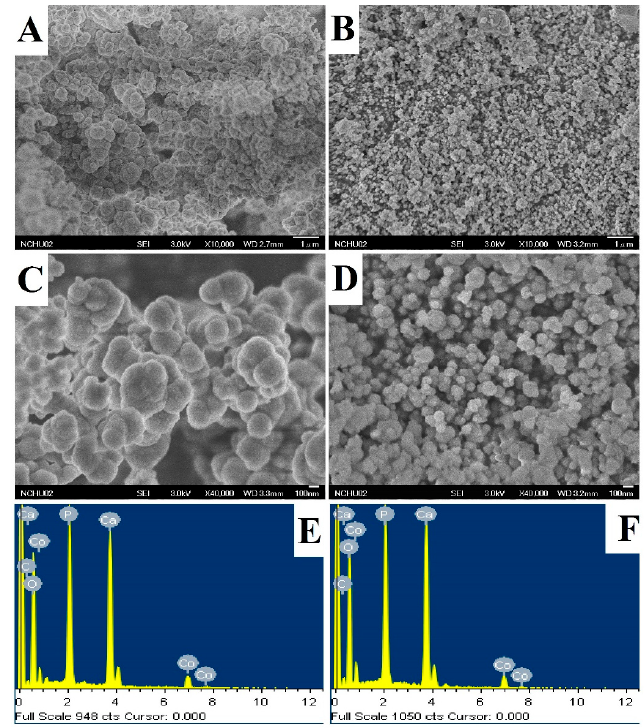
Figure 3. The surface morphology and composition of the ( A,C,E ) Ti ‐ CoHA and ( B,D,F ) TNT ‐ CoHA as observed by FE ‐ SEM and EDS. CoHA stands for cobalt ‐ substituted hydroxyapatite.